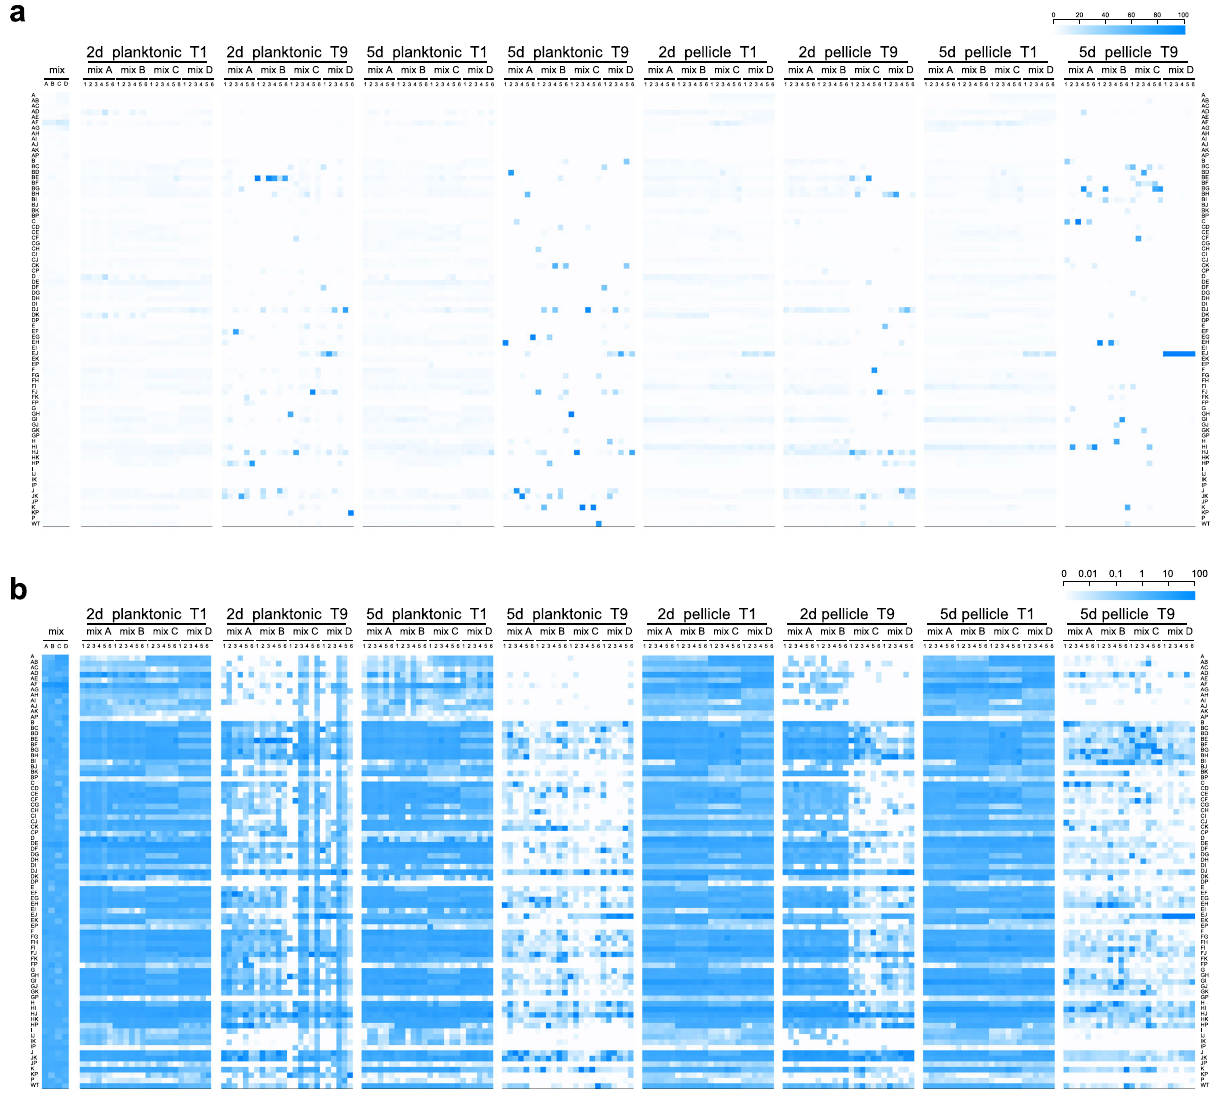
Fig. 2 Heat map representation of the population dynamics of B. subtilis rap – phr mutants in competition. Color intensities of the boxes represent the population percentage of strains. Text columns at far-left and far-right indicate which rap – phr genes have been deleted (A indicates a Δ rapA mutant, AB indicates a Δ rapA Δ rapB mutant, and so on), WT indicates B. subtilis DK1042. Text rows on top indicate type of culture (planktonic or pellicle), incubation period (2d = 2 days, 5d = 5 days), transfer number of represented population (t1 – t9), and mix and replicate number. Competition populations were started from four biologically independent population mixes (A – D), with six technical replicates per mix. The fi rst four box columns indicate the population representation of tested strains in the competition starter mixes. Both panels show the same data, although using different scales (shown in the top-right corner of each panel): a linear increment of percentage, b logarithmic increment of